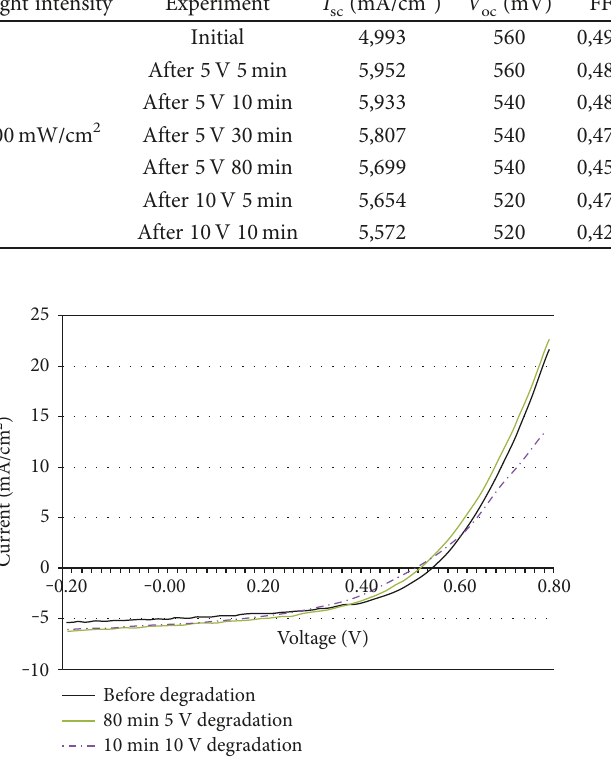
Figure 10: Device 5 fi nger 3 time-dependent voltage degradation I – V curves.